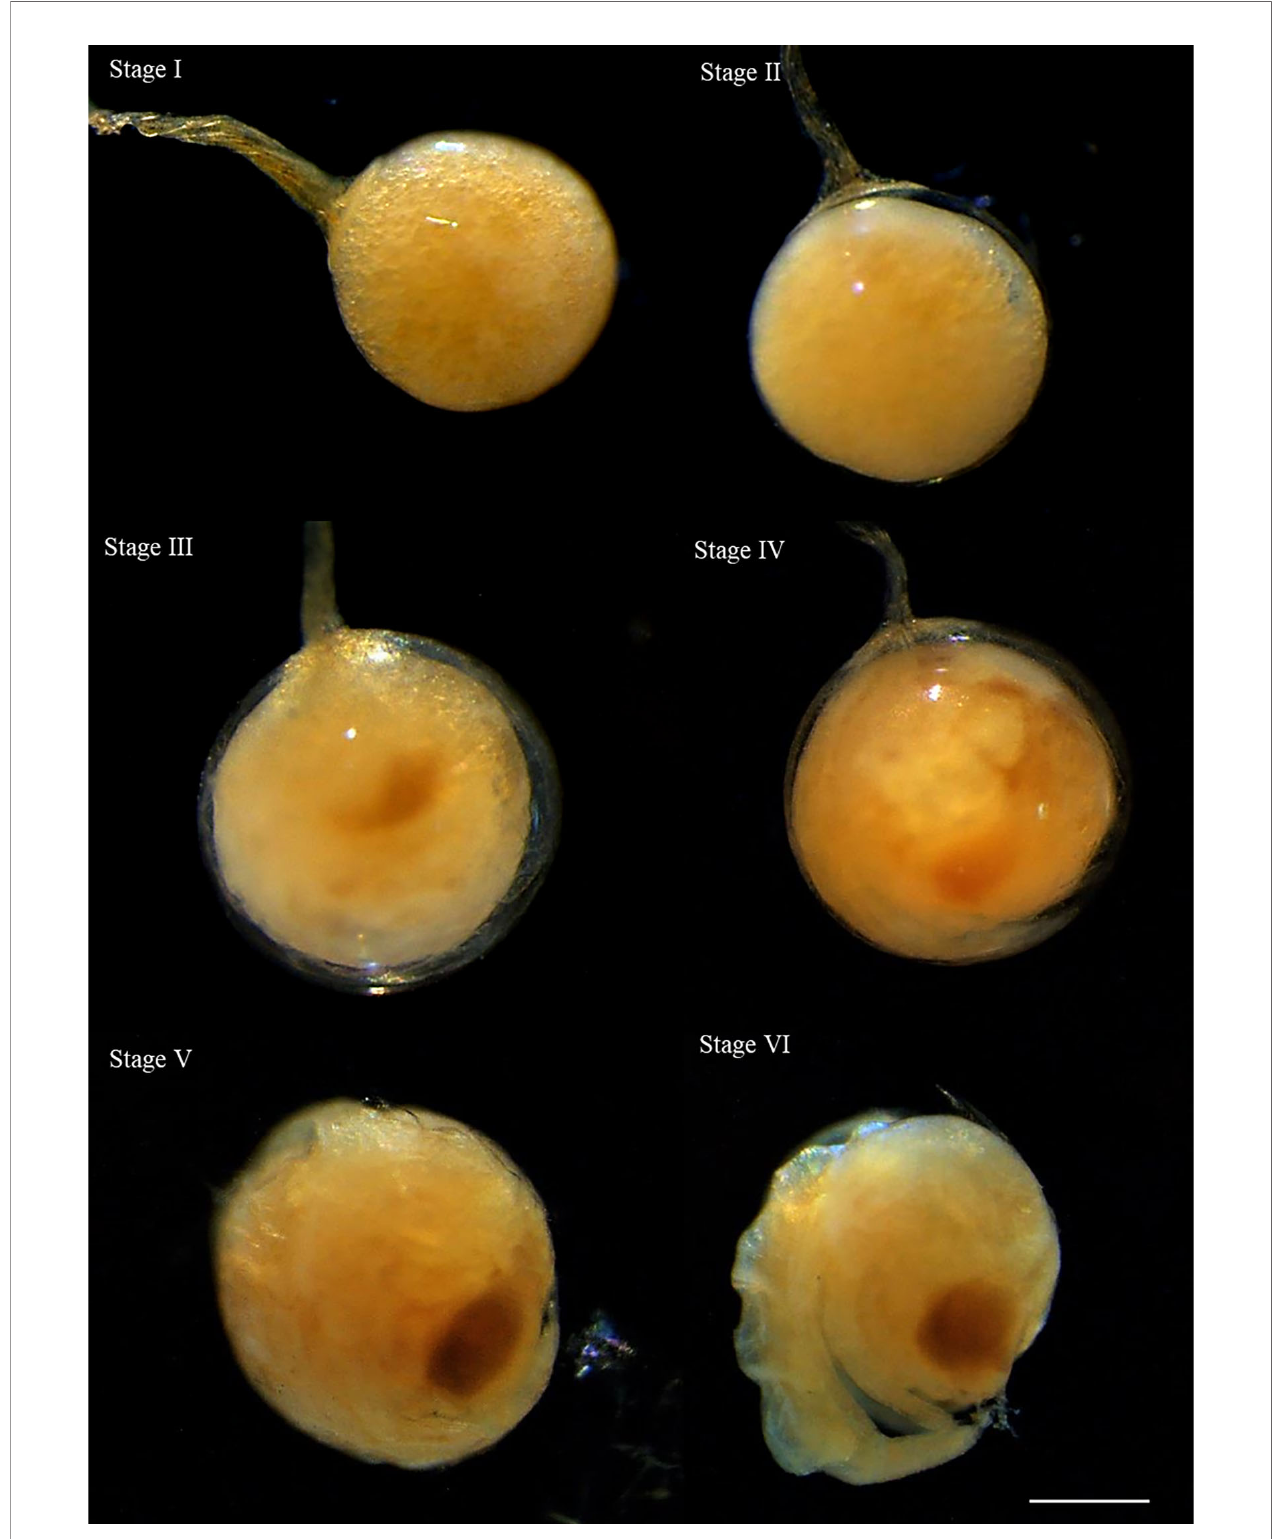
FIGURE 6 | The stages of embryonic development described for Segonzacia mesatlantica taken under Leica MZ16FA. There are present 6 development stages (I, II, III, IV, V, and VI). Scale bars: I - VI = 200 m m.